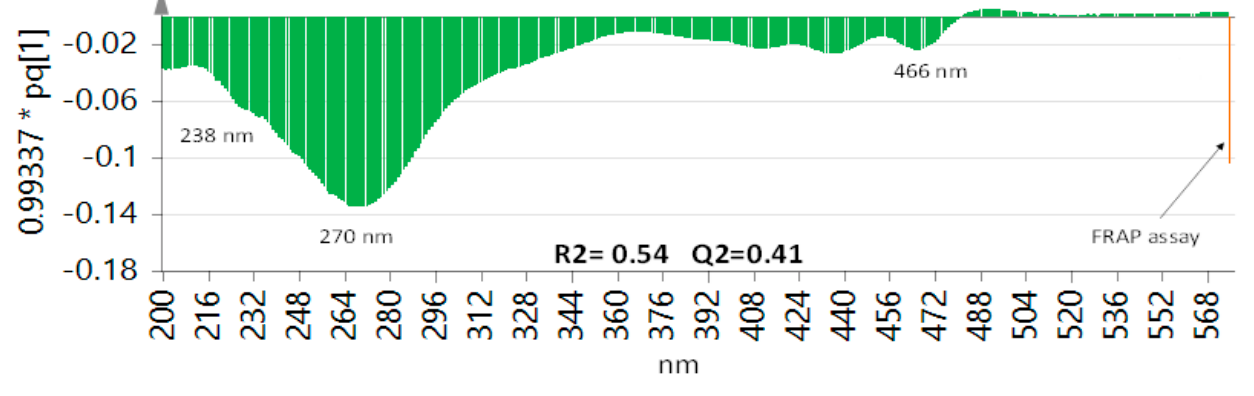
Figure 6. Partial least-squares (PLS) model by assigning UV peak abundance as x-variables and the corresponding FRAP results as